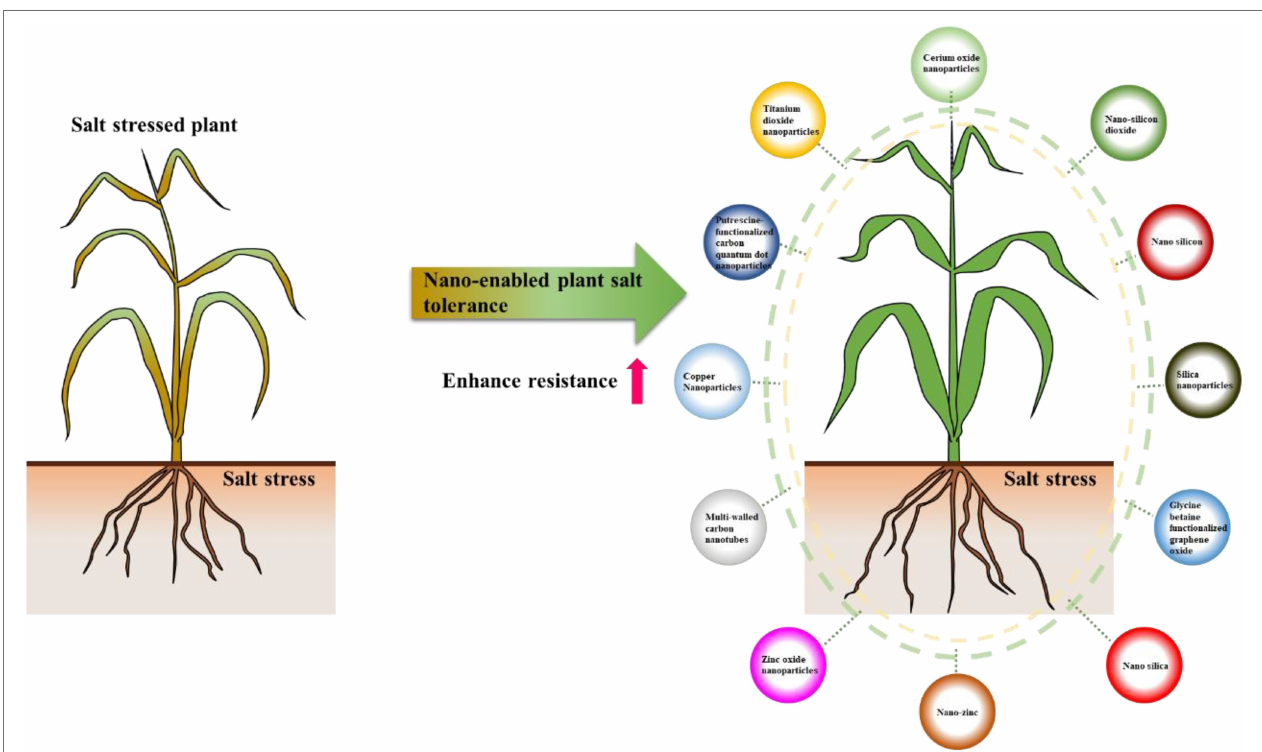
FIGURE 1 | The used nanomaterials for improving plant salt